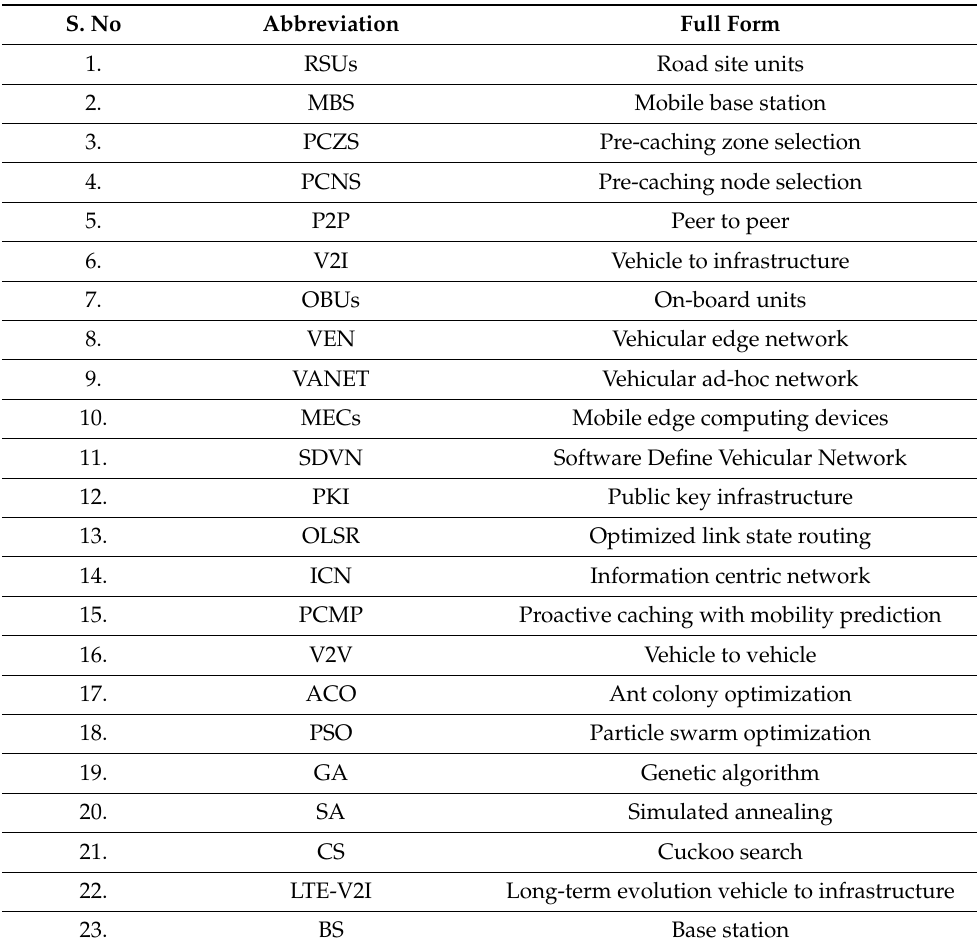
Table 3. Abbreviations and their